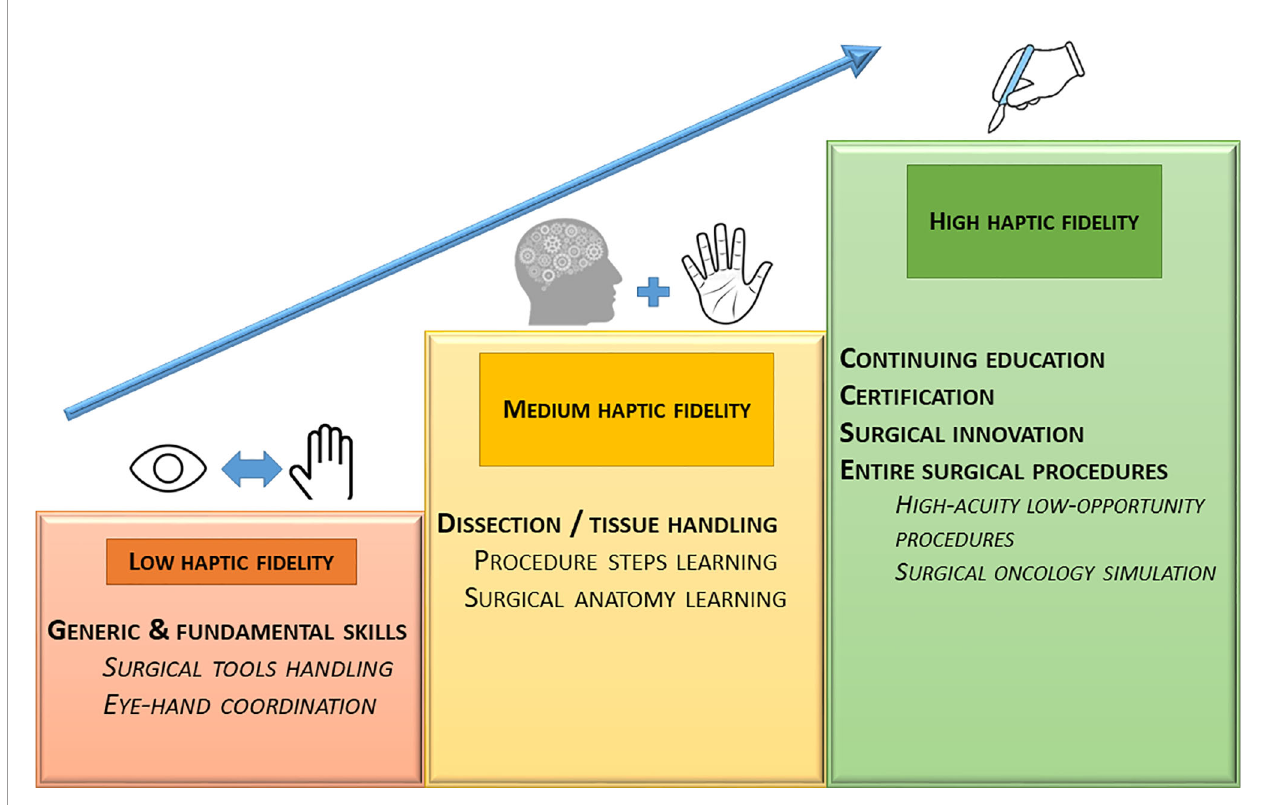
FIGURE 1 | Proposed levels of haptic fi delity and corresponding skills to